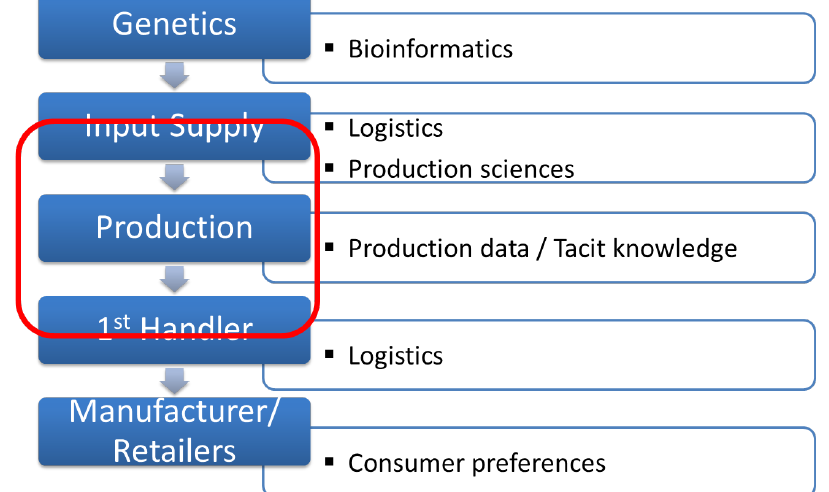
Fig. 8. Subsectors and their key strategic interests relating Big